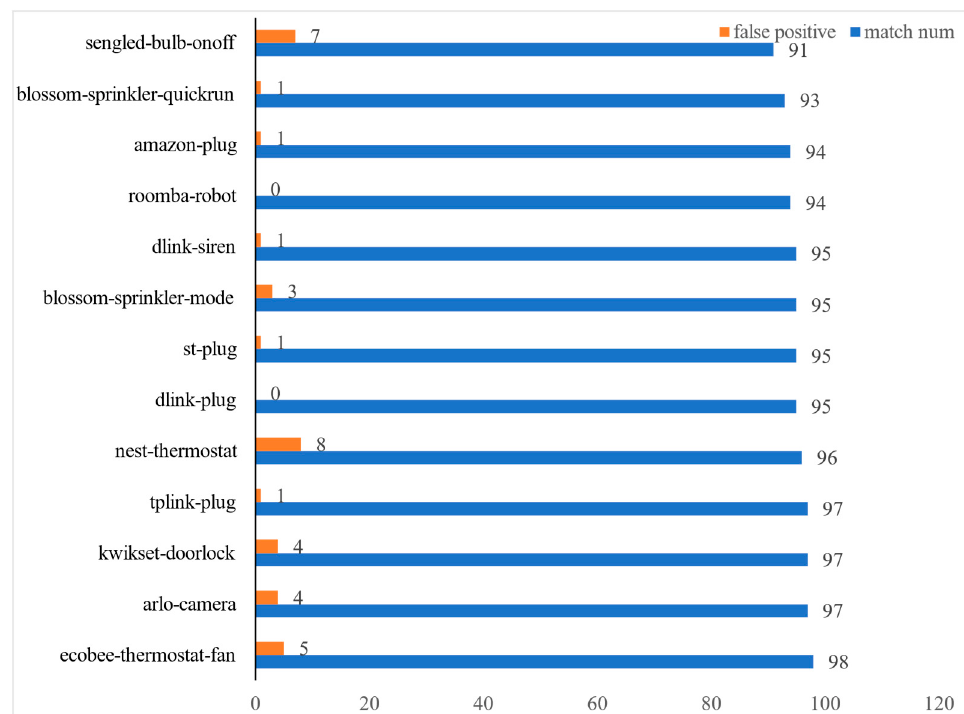
Figure 9. Device matching experiment.